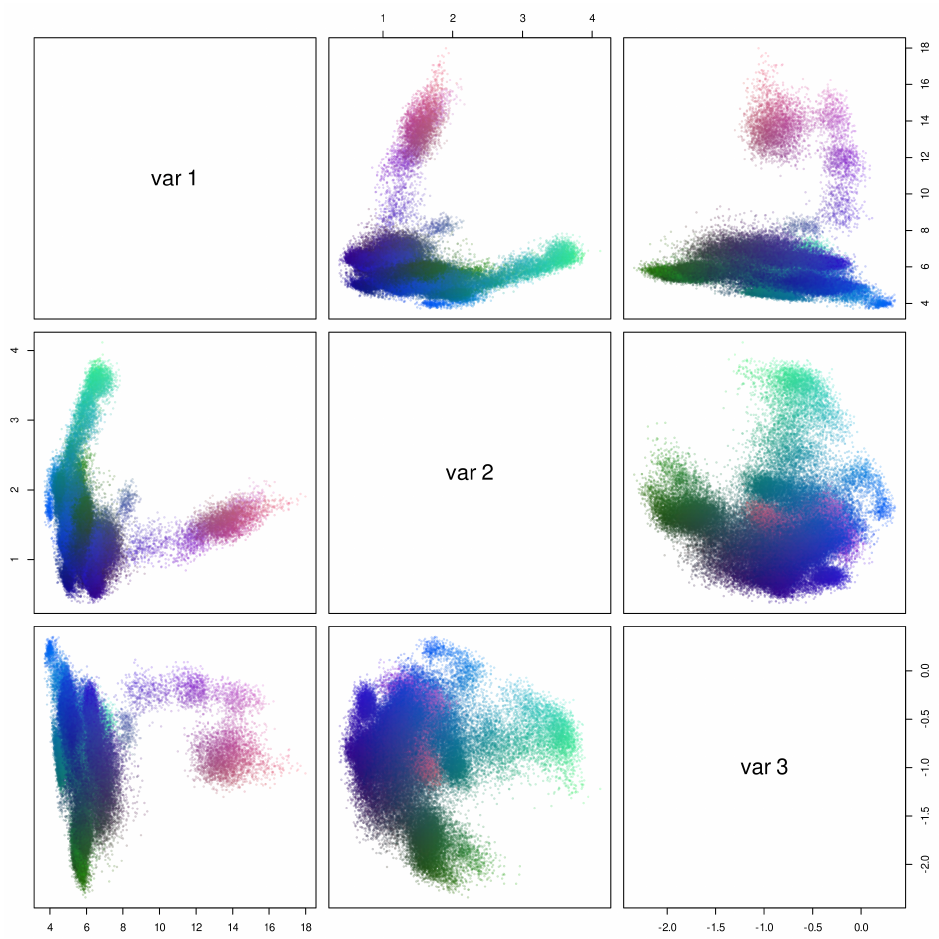
Figure 11. Deep random feature embedding of conformations of the catalytic (SKS) heavy atoms over all trajectories (three highest − variance dimensions). Coloring corresponds to the position on all three dimensions in RGB space (red = first, green = second, blue =